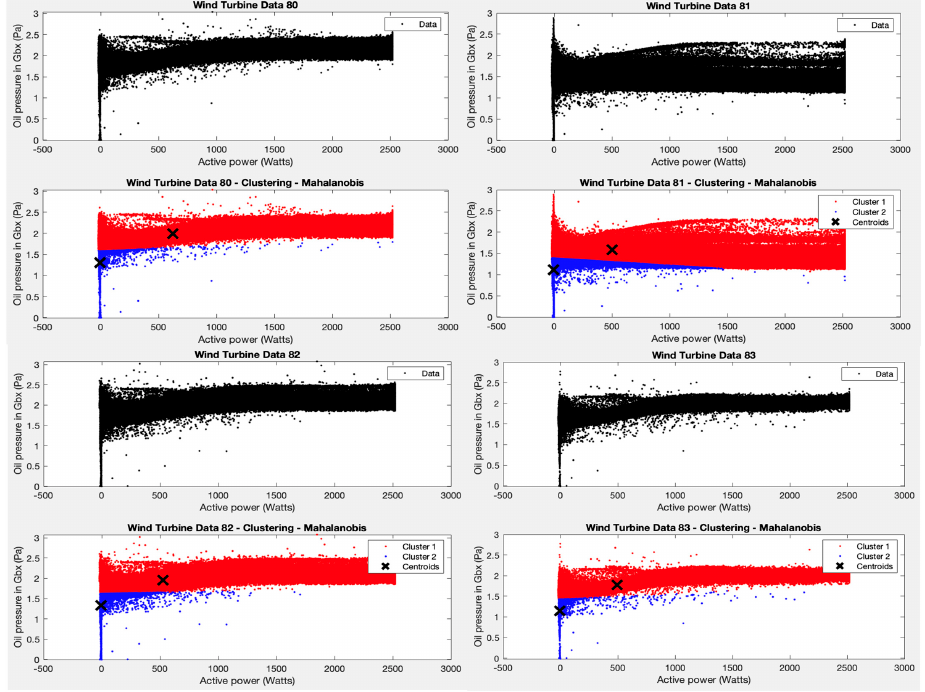
Figure 5. Test 3 results.